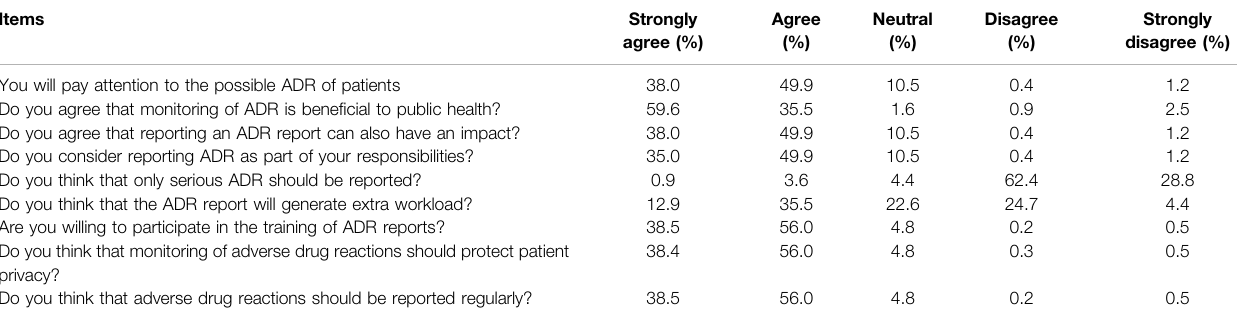
TABLE 2 | Attitudes of pharmacists towards ADR.